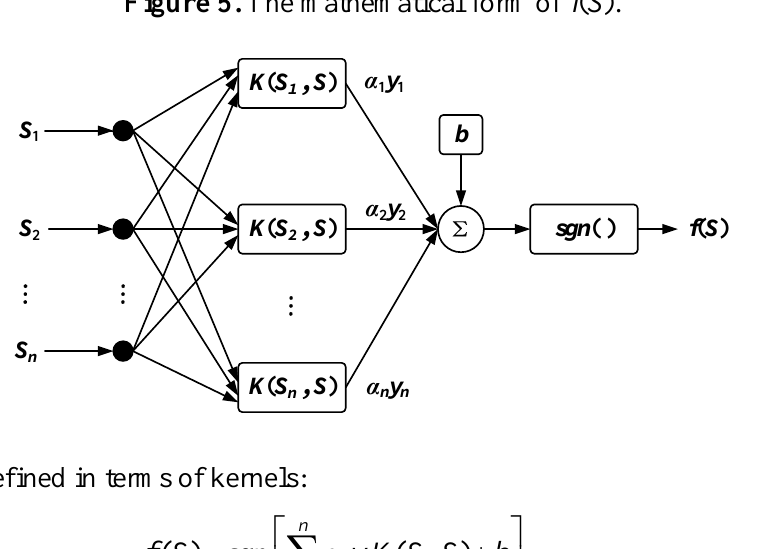
Figure 5. The mathematical form of f ( S